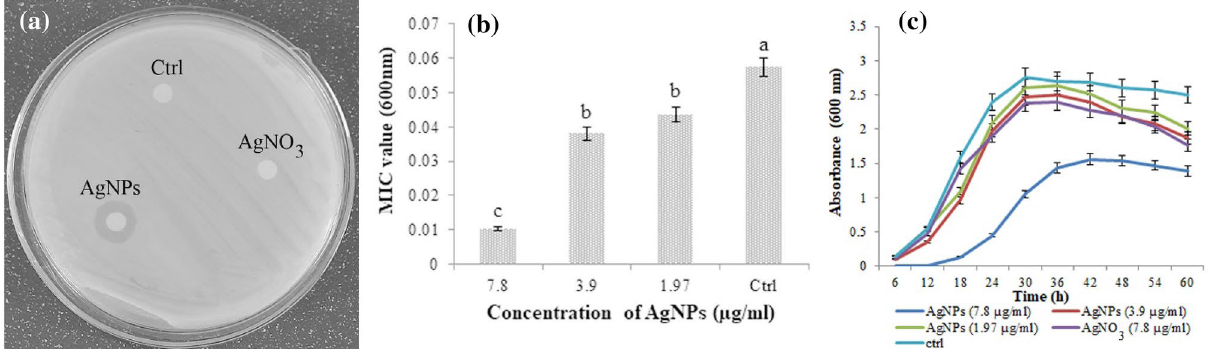
Figure 4. Antibacterial activity of AgNPs against P. tolaasii Pt18, ( a ) measuring inhibition zone sizes around paper disc impregnated with biosynthesized AgNPs, AgNO 3 , and the cell-free supernatant filtrate of P. canadensis Ma1 (Ctrl), ( b ) Minimum inhibitory concentration (MIC) values of AgNPs. Data are presented as mean values with standard errors. Values represented with different letters indicate significant differences between treatments (P = 0.05). At higher concentrations of 7.8 µg/ml, absorption in 600 nm was not recorded. ( c ) Growth kinetics curve of P. tolaasii Pt18 in the presence of 7.8 µg/ml concentration of AgNPs as well as pure silver nanoparticles, and control (Ctrl).